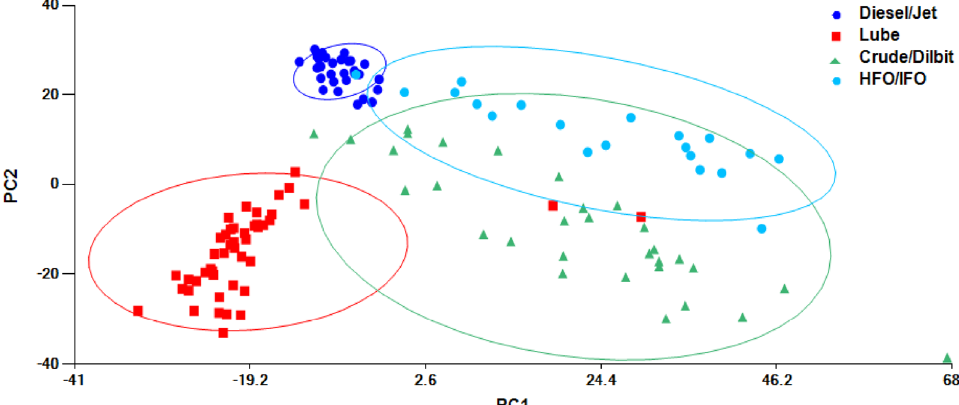
Fig. 5 Two-dimensional principal component analysis scatterplot of reference oil samples. Each reference sample is represented by a